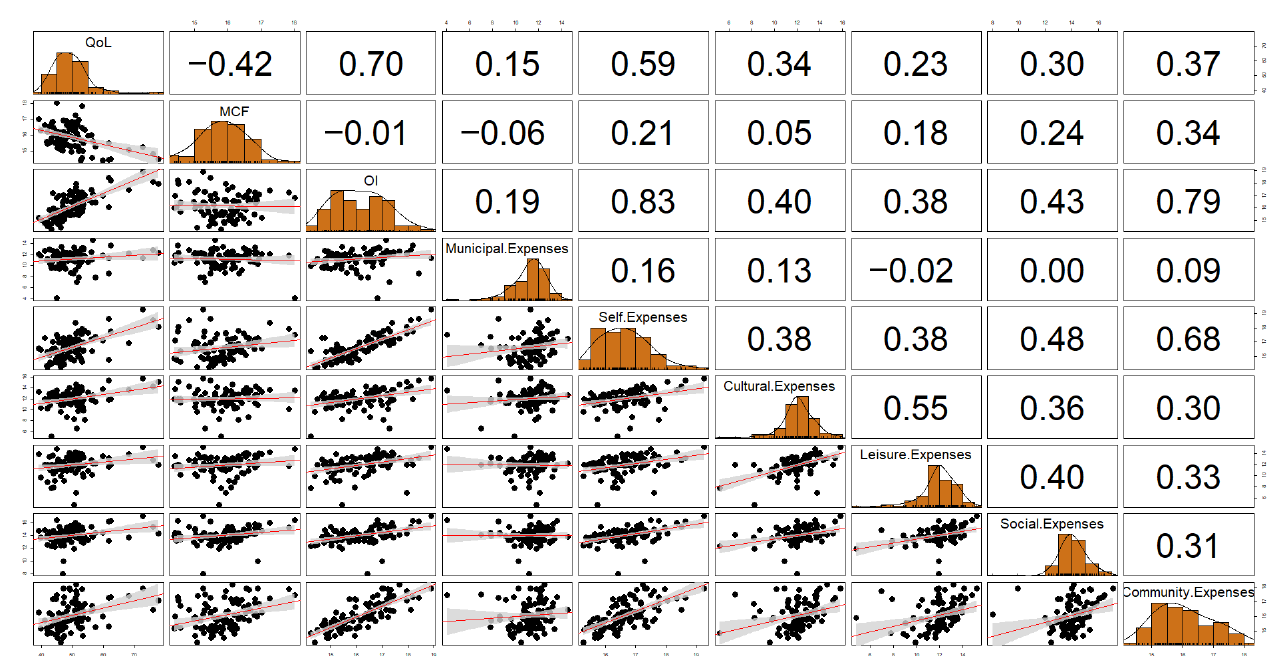
Figure 7. Correlations and scatterplots for quality of life and municipal expenses and public budget variables.